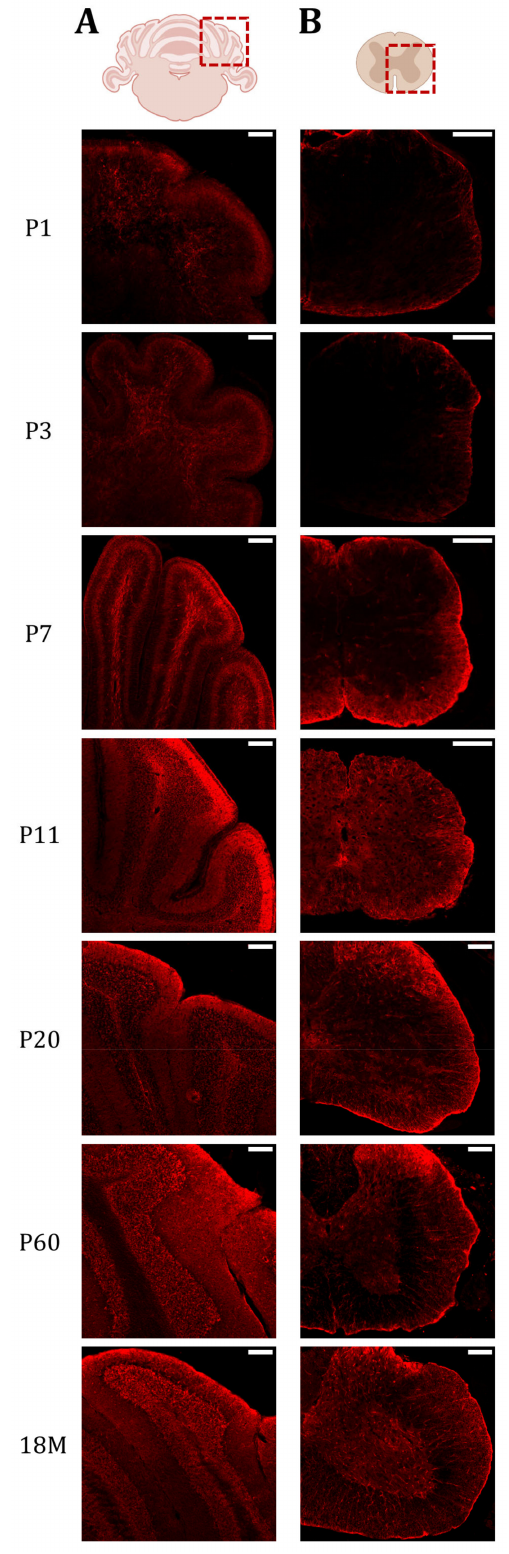
Figure 5. AQP4 protein presence is increased in highly myelinated areas of the cerebellum and spinal cord during postnatal maturation. Fluorescence Immunohistochemistry showing spatiotemporal AQP4 protein distribution (red) in cerebellum ( A ) and lumbar spinal cord ( B ) sections at P1, P3, P7, P11, P20, P60 and 18M. Scale bar = 150 µ m. Illustrations of the cerebellum and spinal cord sections were designed with BioRender (Accessed on 22 November 2022,